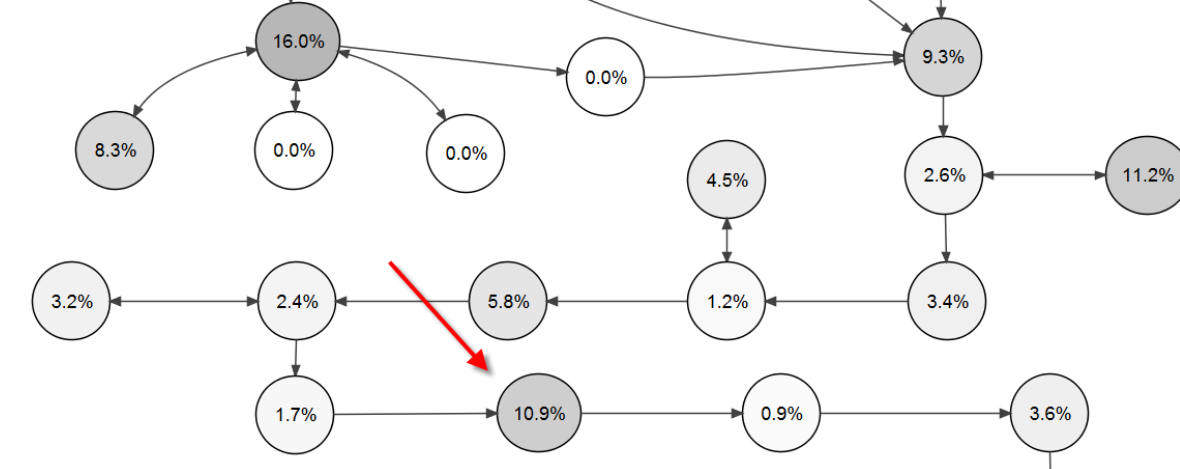
Figure 7. Percentage of visitors who left the virtual patient after visiting the particular screen card.